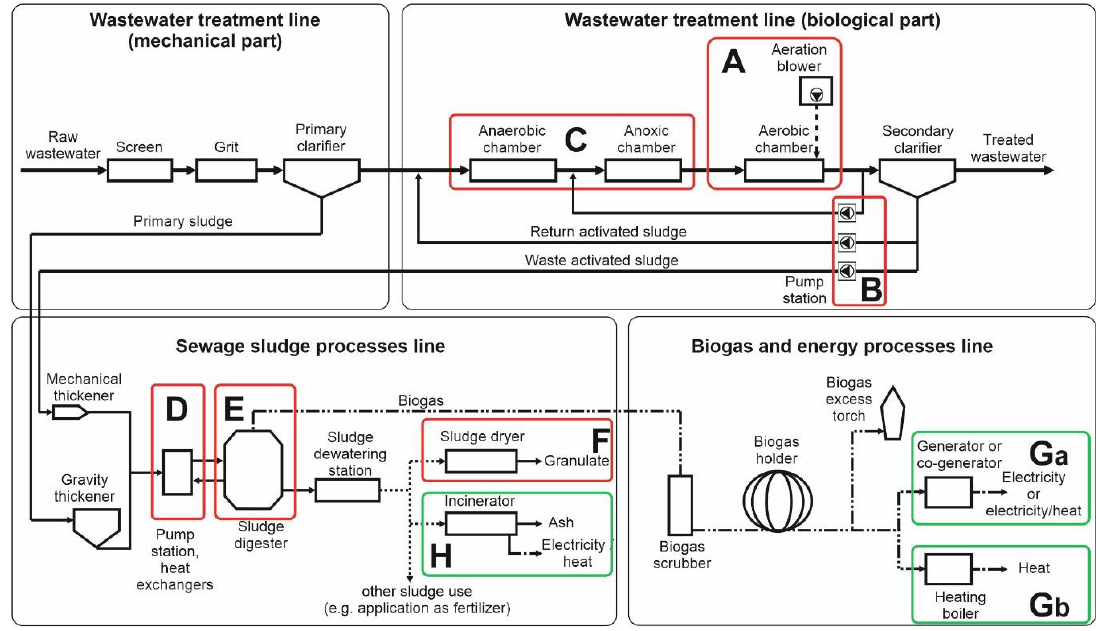
Figure 2. Scheme of a WWTP showing the objects contributing to the consumption and gains of electrical and thermal energy ( authors’ own elaboration based on Dymaczewski and Szulc [29]).